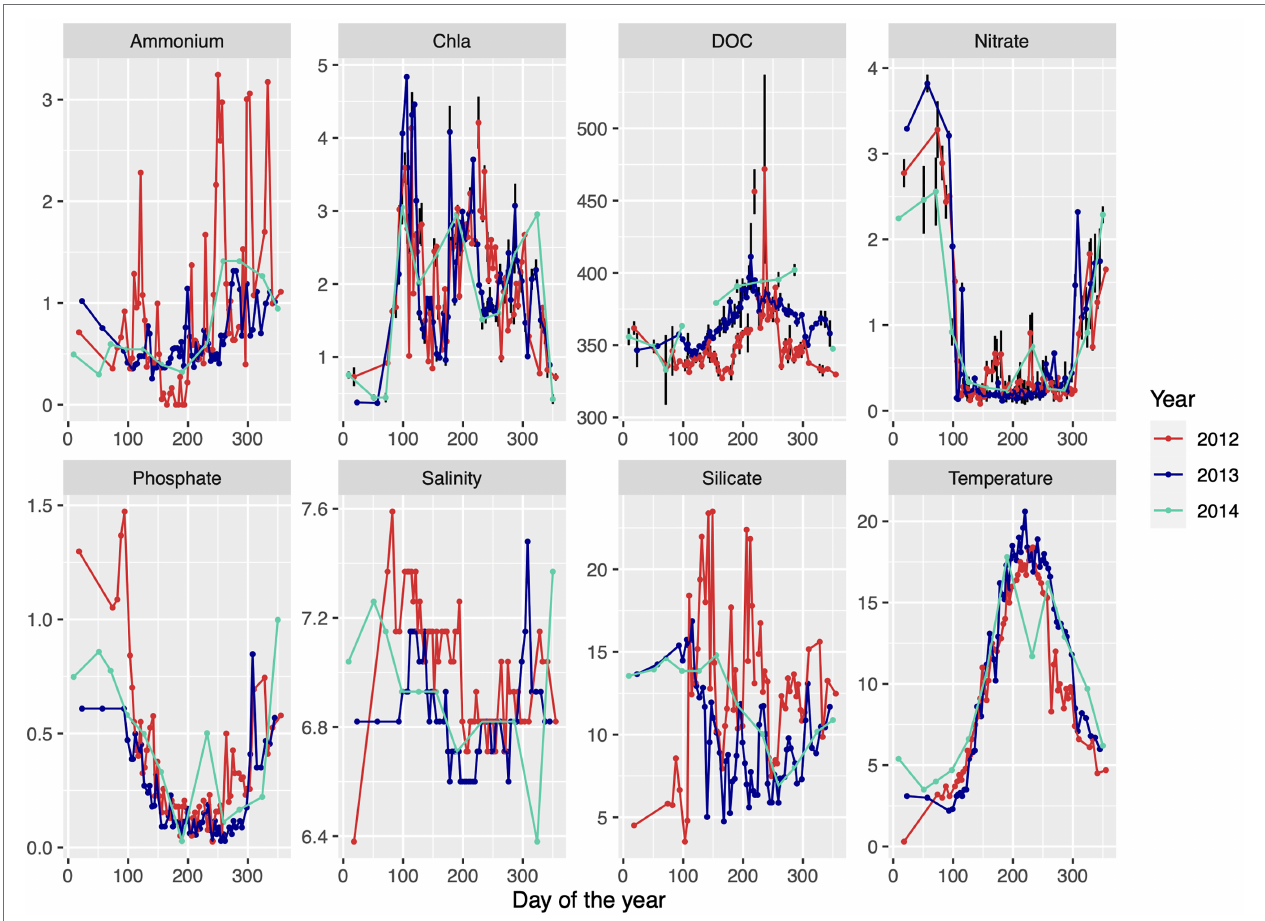
FIGURE 1 | Environmental data of ammonium ( μ mol L − 1 ), chlorophyll a ( μ g L − 1 ), dissolved organic carbon (DOC; μ mol C L − 1 ), nitrate ( μ mol L − 1 ), phosphate ( μ mol L − 1 ), salinity (PSU), silicate ( μ mol L − 1 ), and temperature ( ° C) over three consecutive seasons throughout 2012 until 2014 at the Linnaeus Microbial Observatory (LMO) sampling site, off the island of Öland, Sweden, in the southwest Baltic Proper. Data are redrawn from Lindh et al. (2015) and Bunse et al. (2019) and denote averages of technical